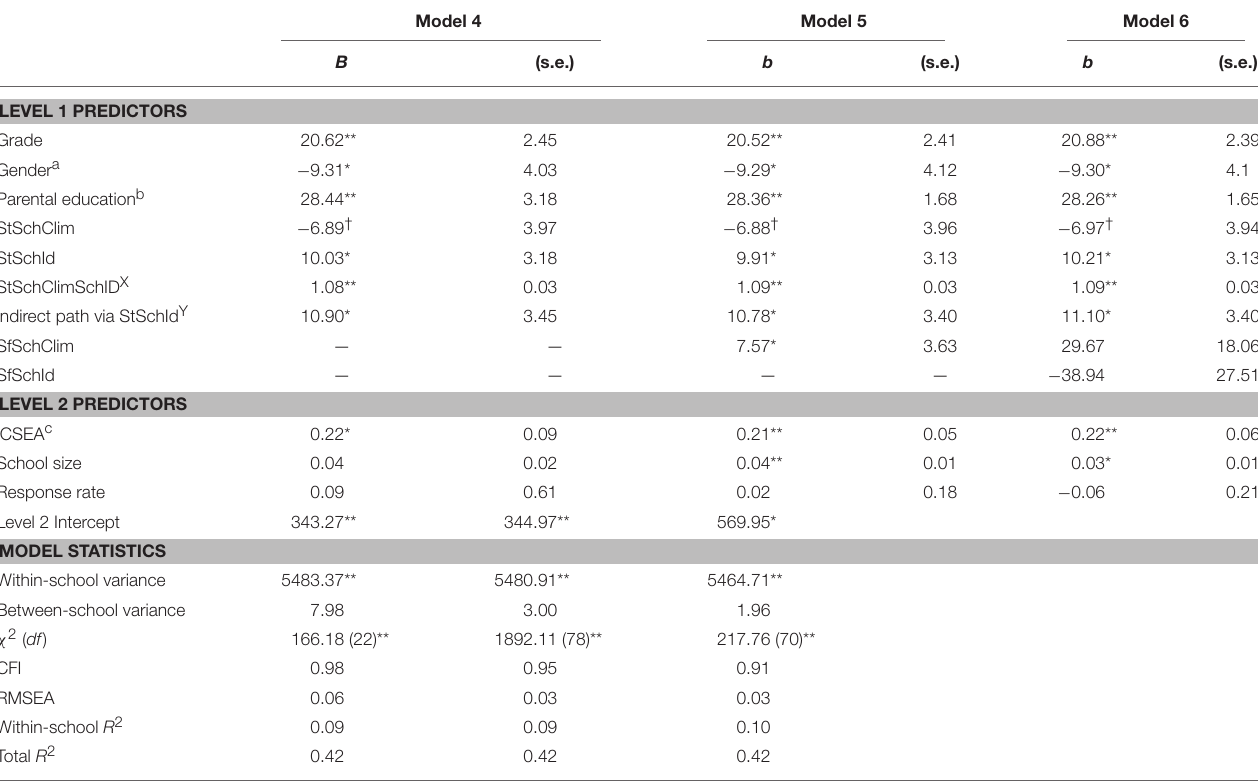
TABLE 4 | Multilevel SEM results for models 4–6 explaining NAPLAN